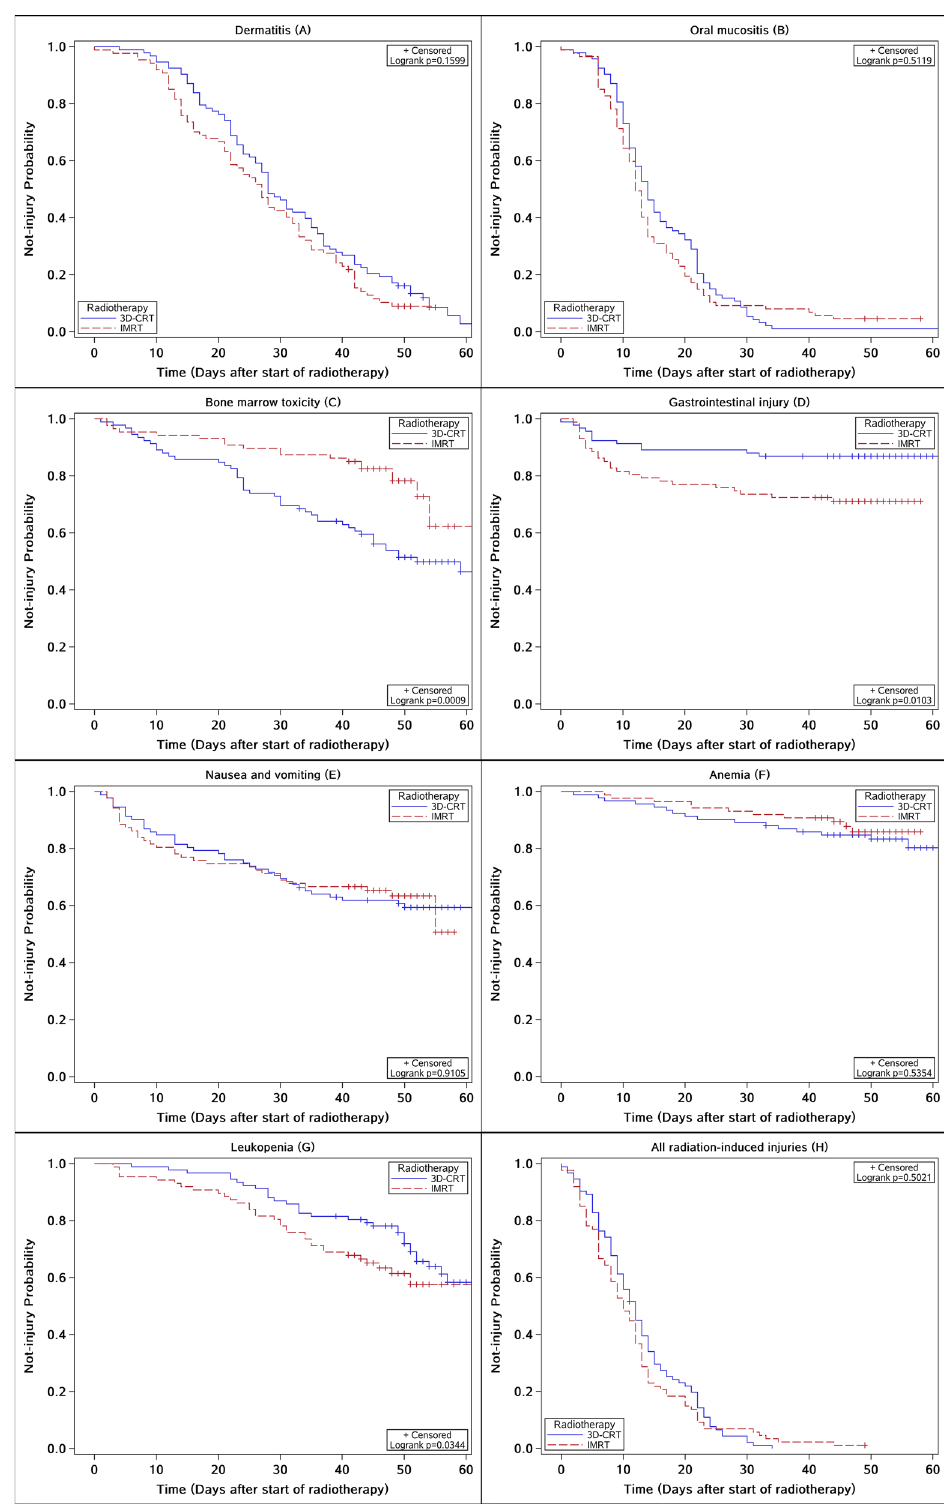
Figure 3. Kaplan–Meier curves for dermatitis ( A ), oral mucositis ( B ), bone marrow toxicity ( C ), gastrointestinal injury ( D ), nausea and vomiting ( E ), anemia ( F ), leukopenia ( G ) and all radiation-induced injuries ( H ) in NPC patients treated with IMRT versus